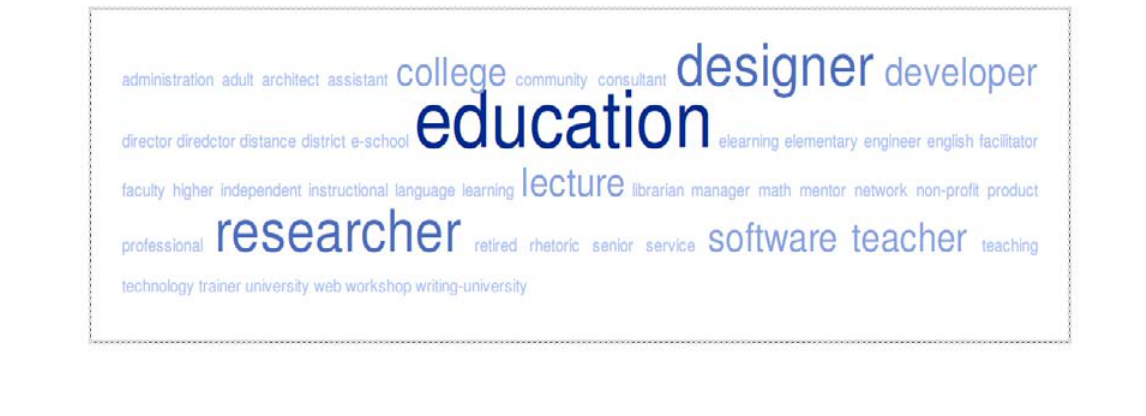
Figure 1 . Wordle of participants’ professional backgrounds.